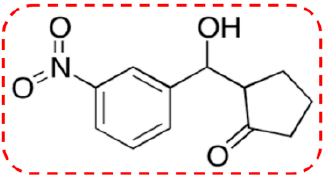
Figure 1. Chemical structure of 2-(hydroxy-(3-nitrophenyl)methyl)cyclopentanone.